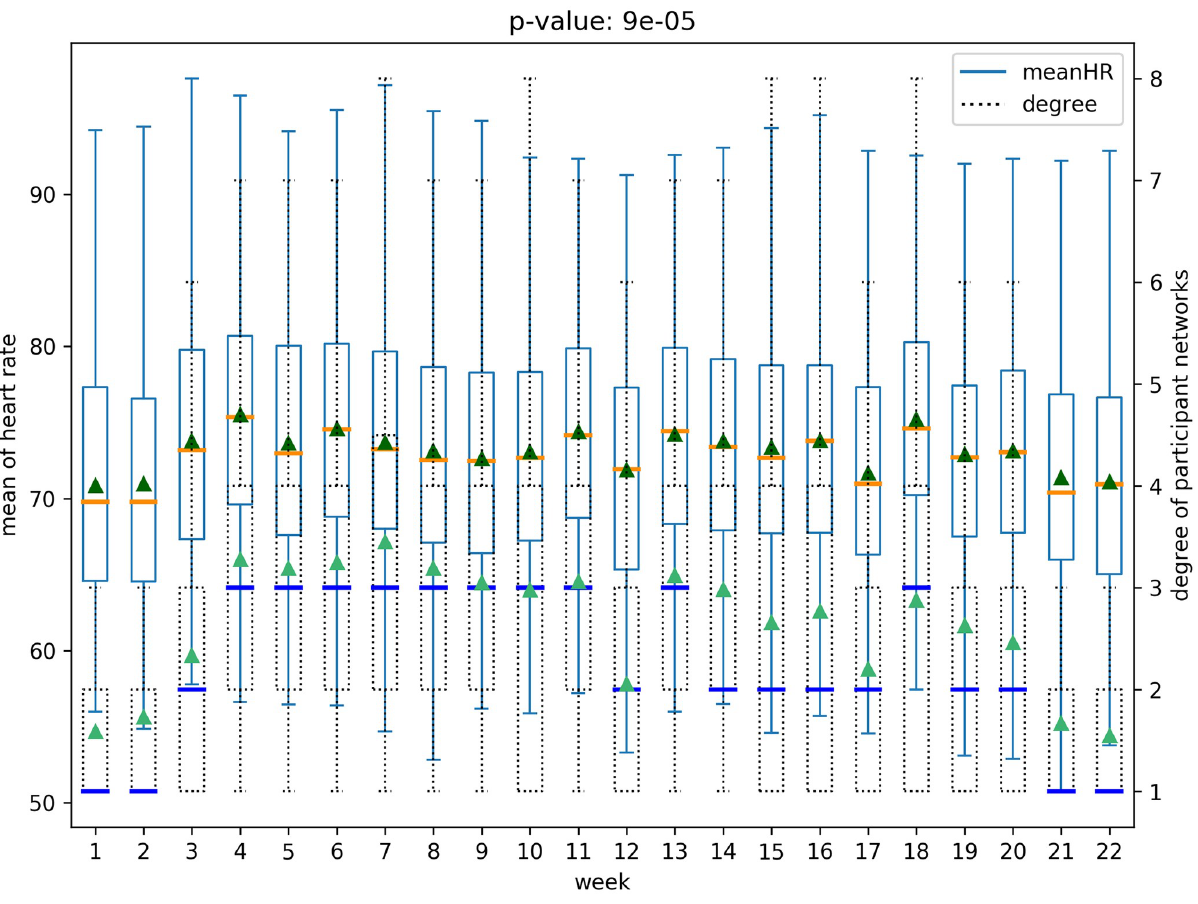
Fig 5. Relation between heart rate and degree of participant network